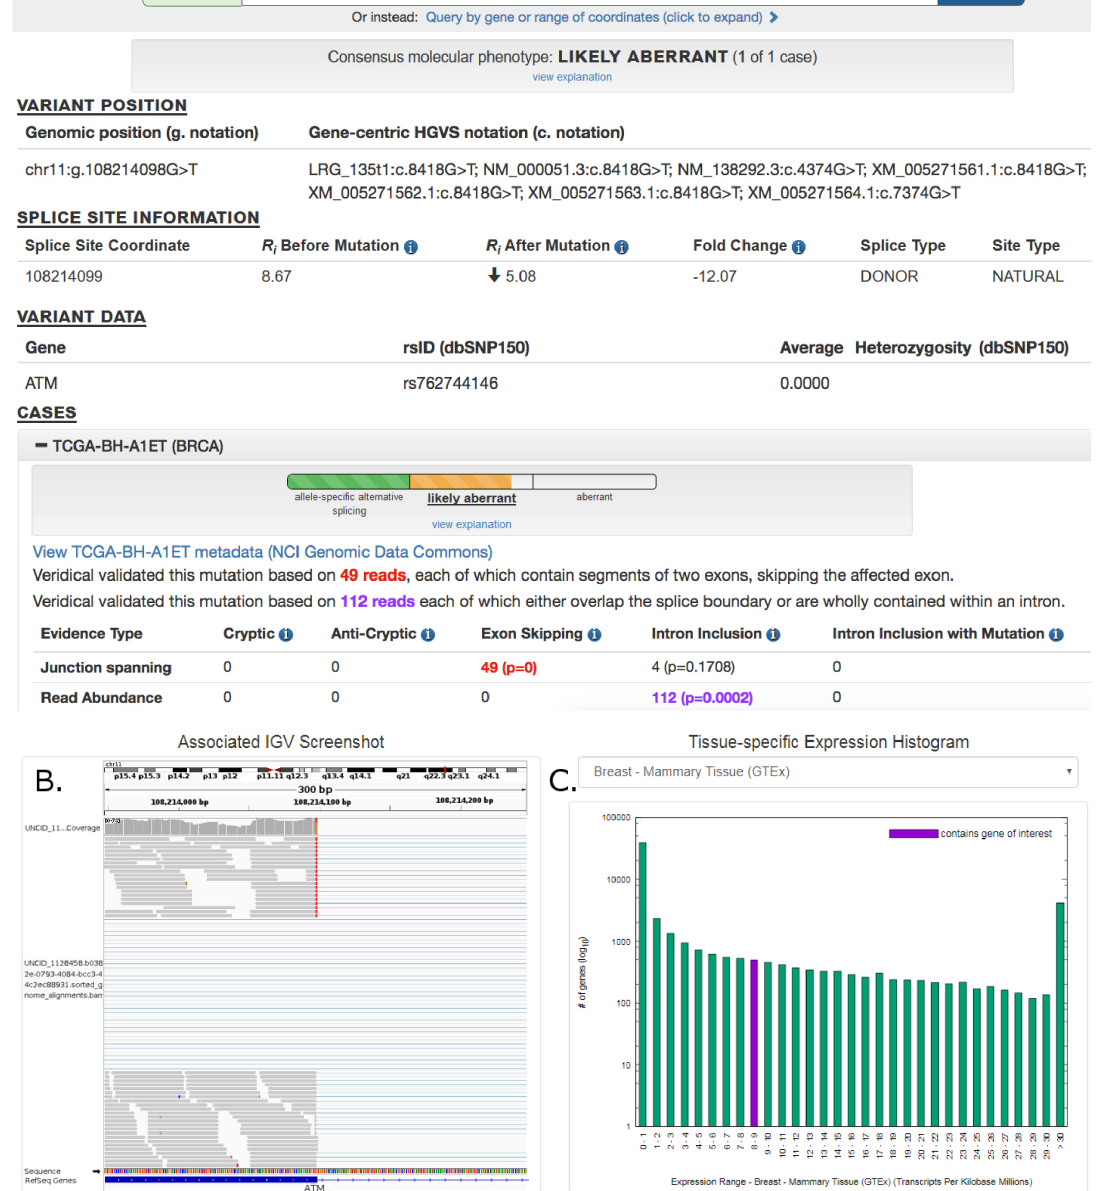
Figure 1. Screenshot of ATM :g.108214098G>T Results Provided By ValidSpliceMut Website. ( A ) At the top of the page, the predicted molecular phenotype of the mutation for all cases is presented (prediction algorithm is shown in Figure 2). Then, the ‘Variant Position’ heading displays the variant of interest in g. notation, and provides a link which queries the Mutalyzer API to obtain the variant coordinate in a gene- centric c. mutation format. Variant-specific and splice site-specific tabular results are presented under the headings “Splice Site Information” and “Variant Data”. Results are then organized by TCGA and ICGC sample IDs (‘cases’) harboring the mutation within a series of expandable panels. A link is provided to patient tumor metadata on the GDC data portal. Each panel consists of the molecular phenotype classification for that particular sample, and the read counts and p-values for each Veridical evidence type. Significant p-values ( ≤ 0.05) are highlighted in bold. Evidence types deemed “strongly corroborating” (Viner et al. 2014) are color coded and correspond to the dynamically generated text appearing above the table. ( B ) An integrative genome viewer (IGV) image showing alignment of expressed sequence reads. IGV screenshots are provided only for mutations present <1% of population (in dbSNP 150), with ≥ 5 junction-spanning reads, and are highly significant (p < 0.01) for cryptic splicing, exon skipping, and/or intron inclusion with mutation. A specific IGV screenshot for this sample captures the region surrounding the mutation. Here, several RNA-Seq reads show skipping of the affected exon. ( C ) A dynamically generated histogram presents expression levels of all genes for a selected normal tissue type. Genes are grouped into bins based on expression level, denoted on the x-axis. The number of genes present in each bin is shown on the y-axis (log scale). The histogram key indicates the expression range 10 which contains the variant-containing gene (purple). Tissue type can be changed via a drop-down